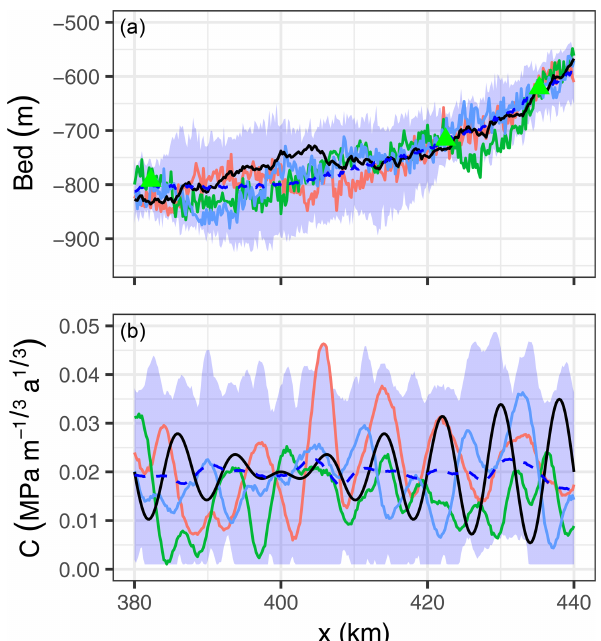
Figure 5. For the initial ensemble for the bed and friction coeffi- cient, the ensemble mean is the dashed blue curve, and the shad- ing shows the ensemble spread. Coloured solid lines show the first three members. The reference is shown in black and the synthetic bed measurements are shown as green triangles.